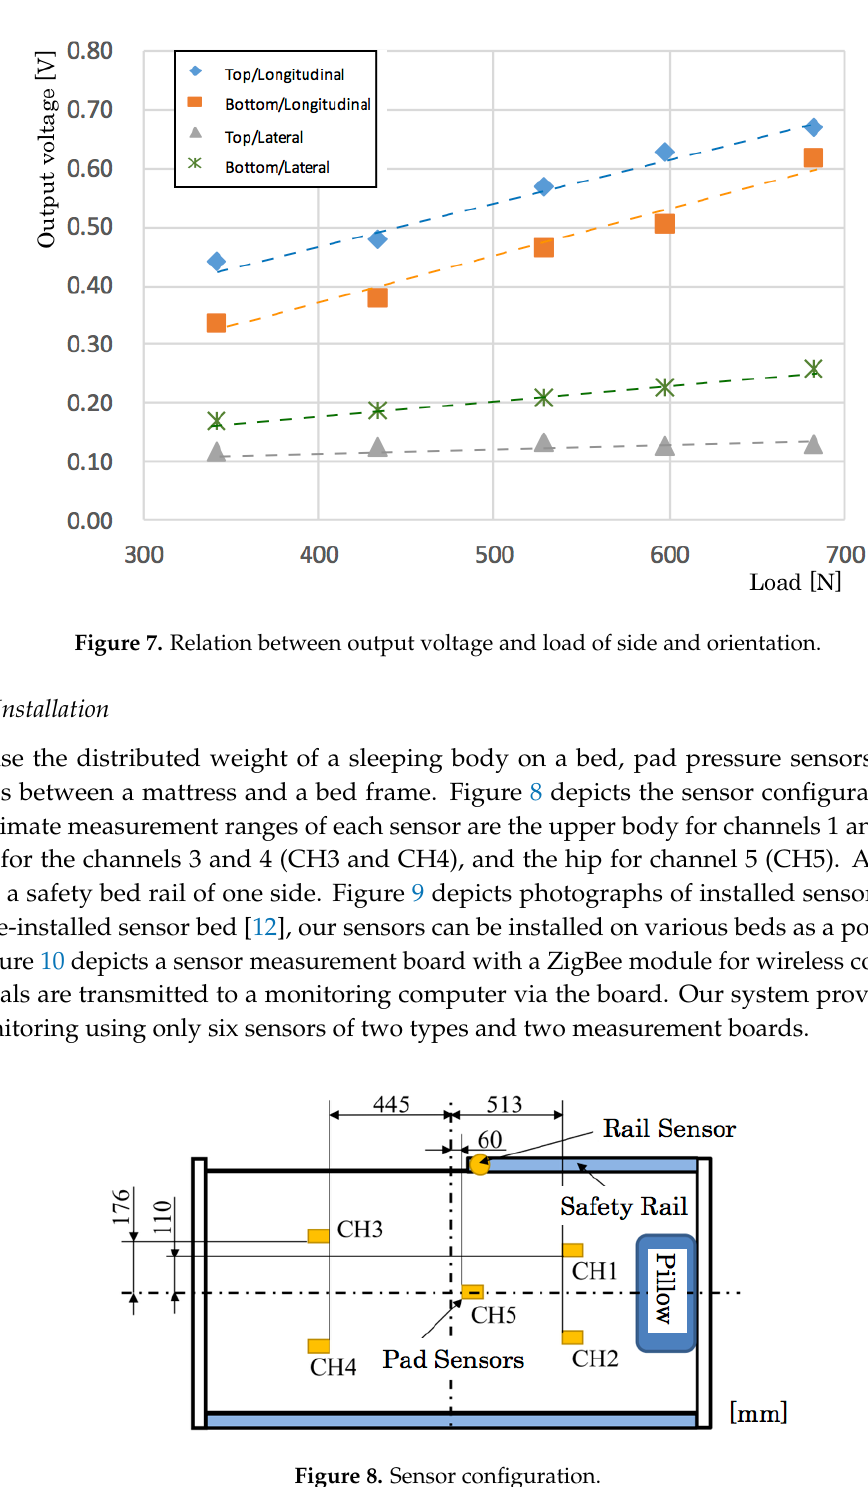
Figure 8. Sensor